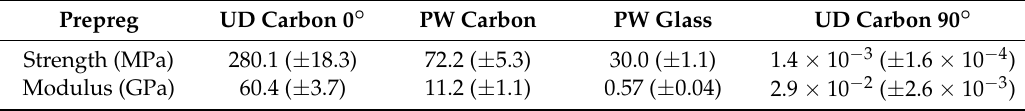
Table 3. Average and standard deviation of strength and Young’s modulus from three repeated measurements for unidirectional (UD) 0° (red), PW carbon (green), PW glass (blue) and UD carbon 90° at 100 °C.